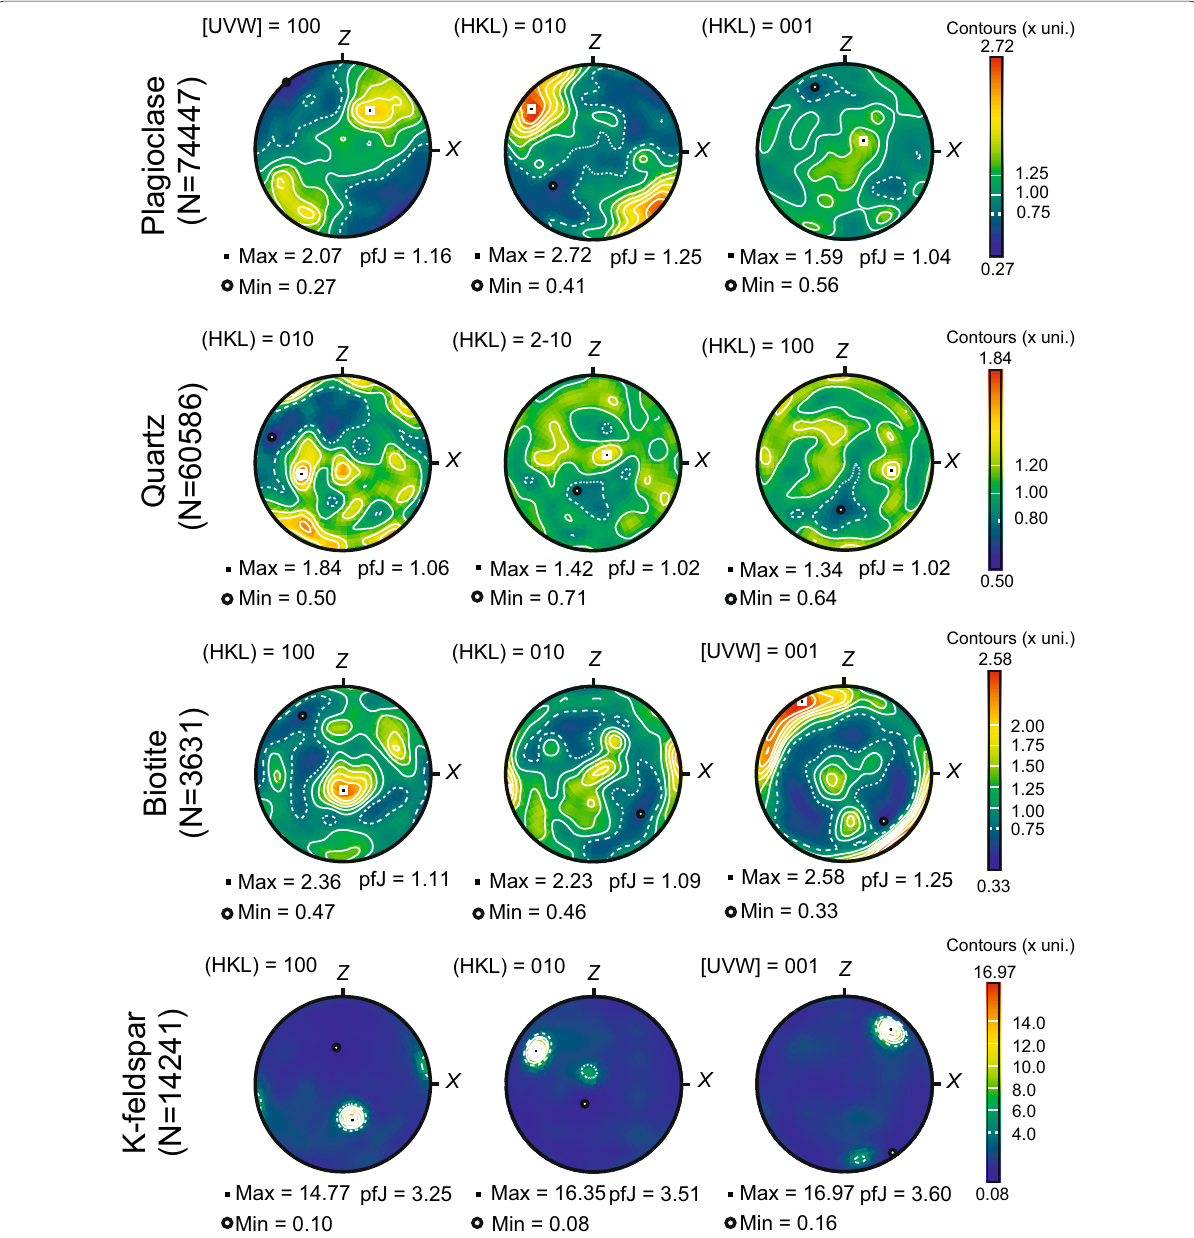
Fig. 1 Pole figures of crystallographic orientation of plagioclase, quartz, biotite and K-feldspar. X - and Z -directions are the radial and axial directions of a cylindrical sample AJG02. Pole figures are equal-area lower-hemisphere projections with a Gaussian half-width angle of 8.5º. Contours represent the data points (multiples of uniform density). The maximum and minimum density values are shown. The pfJ index was proposed by Michibayashi and Mainprice (2004) to evaluate the fabric strength. The number of measured points is denoted by